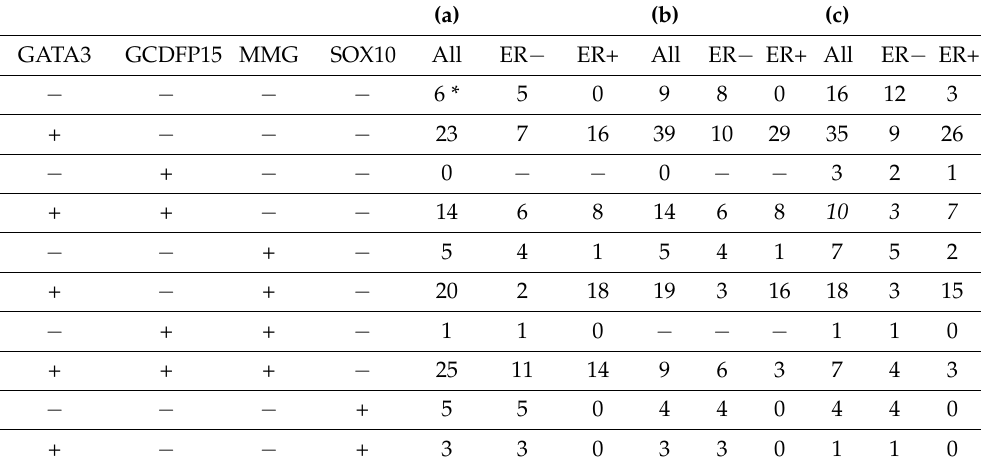
Table 4. Comparison of co-expression pattern of estrogen receptor (ER), GATA3, gross cystic dis- ease fluid protein-15 (GCDFP15), mammaglobin (MMG) and SOX10.